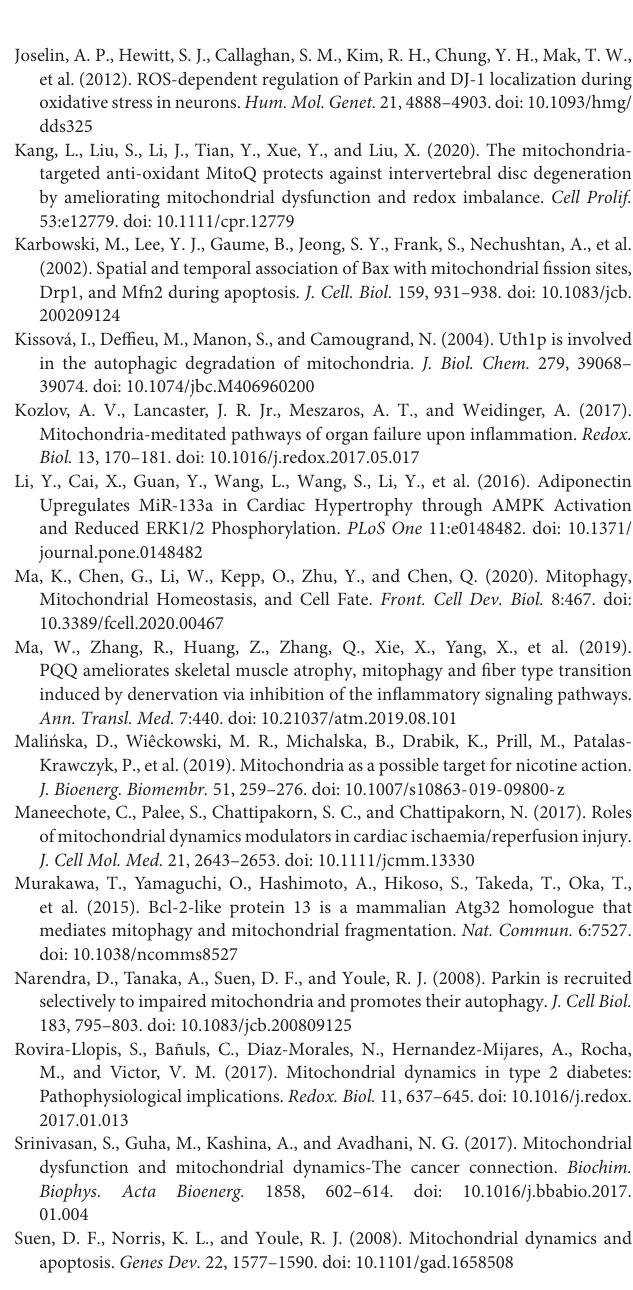
Supplementary Figure 2 | (A) TUNEL assay of NRVMs with mdivi-1 pretreatment (Scale bar=50 µ m). (B) RFP-GFP-Fis1 transfection were used to test the effect of Mdivi-1(Scale bar = 20 µ